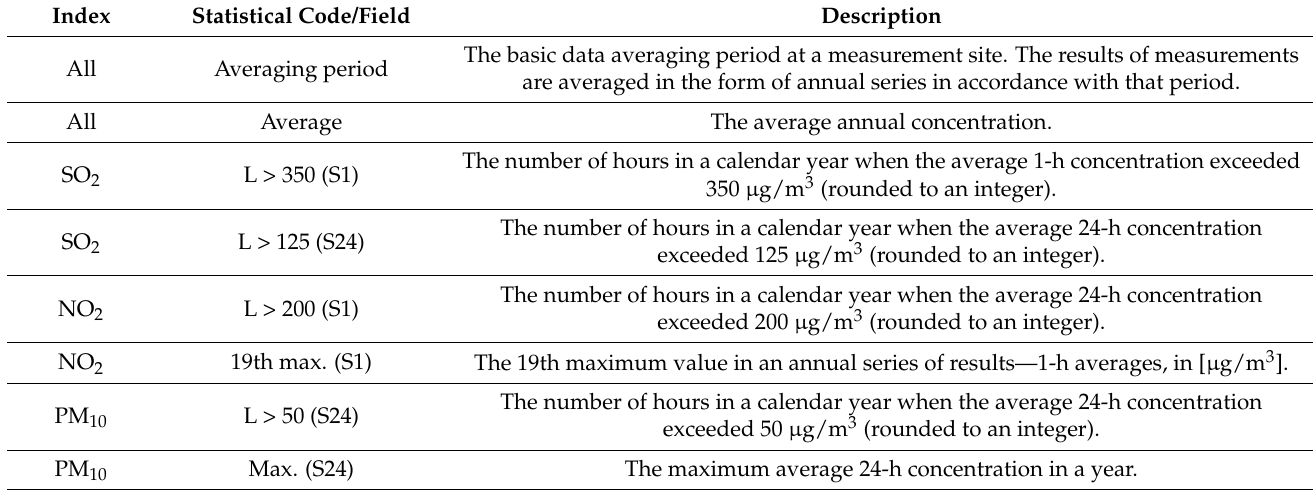
Table 2. Descriptions and units of the measurements and pollutants. Source: